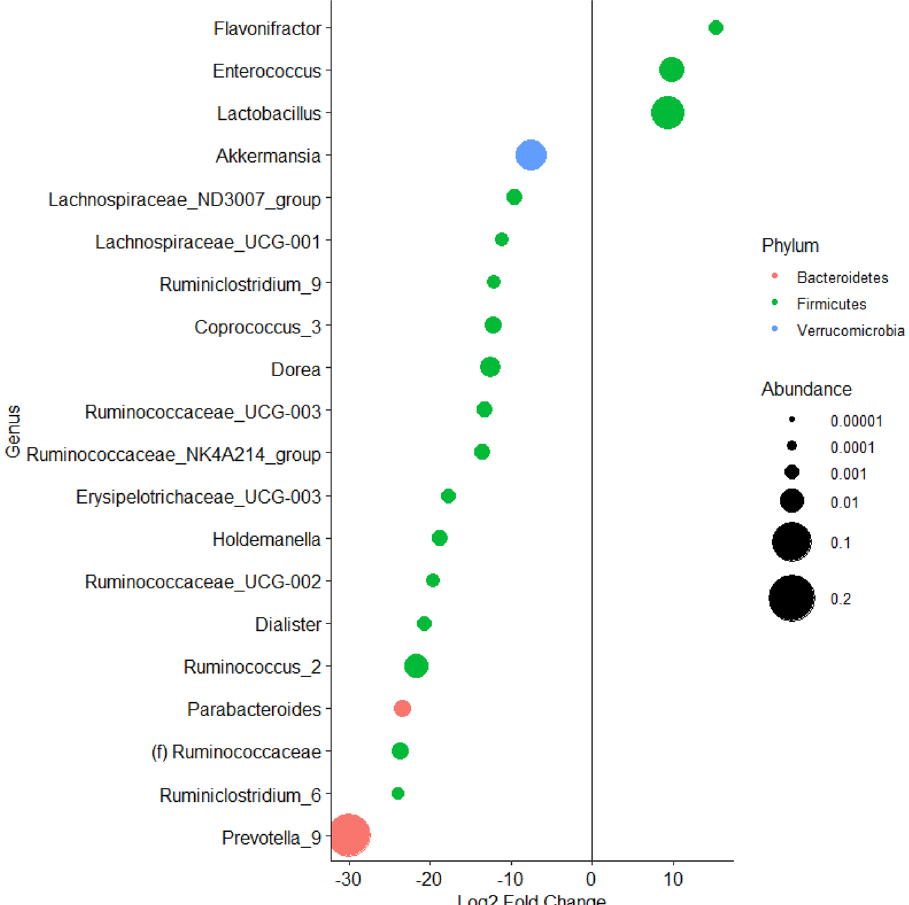
Figure 3. Plot showing Log2(fold-change) of bacterial genera abundance in samples from patients with increased IL-1α levels post-intervention compared to samples from patients with reduced IL-1α levels post- intervention. Each dot represents one bacterial genus and is colored by phylum and sized according to average relative